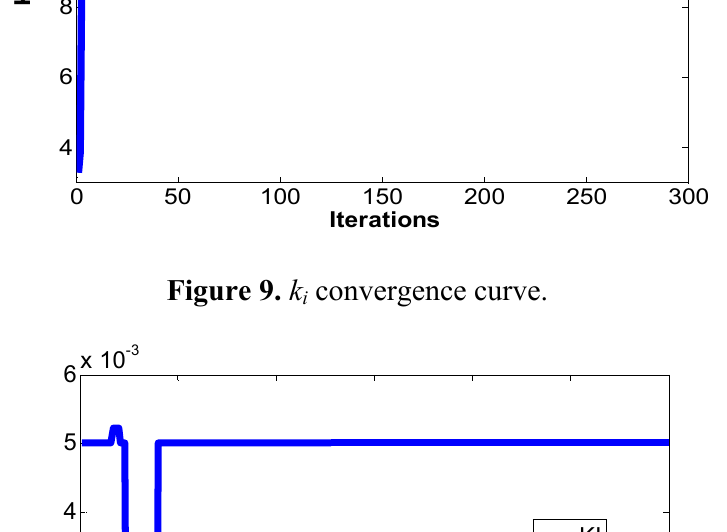
convergence curve. i